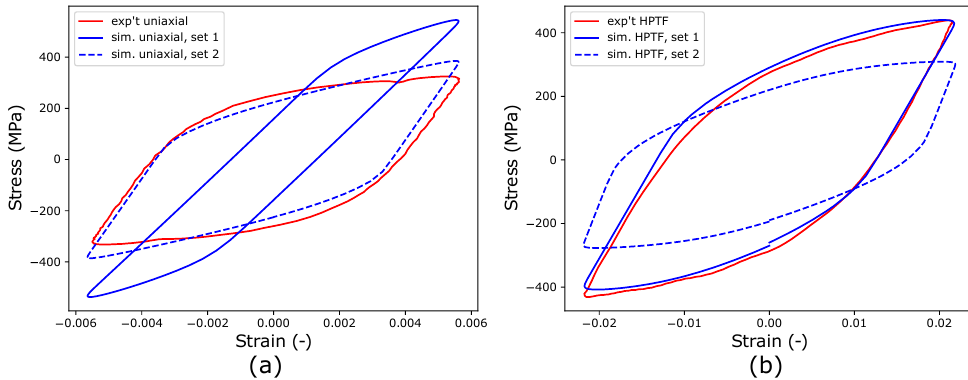
Figure 13. Comparison of experimental and simulated stress–strain hysteresis loops ( a ) for uniaxial fatigue with the strain amplitude E 33 = 0.55% and ( b ) under HPTF loading with ( R = − 1, θ = 7.5 ◦ , E 13 = 0.02). The material parameters for set 1 (Table 5) were obtained using an inverse analysis of the HPTF experiments, whereas the parameters of set 2 (Table 6) were fitted to uniaxial